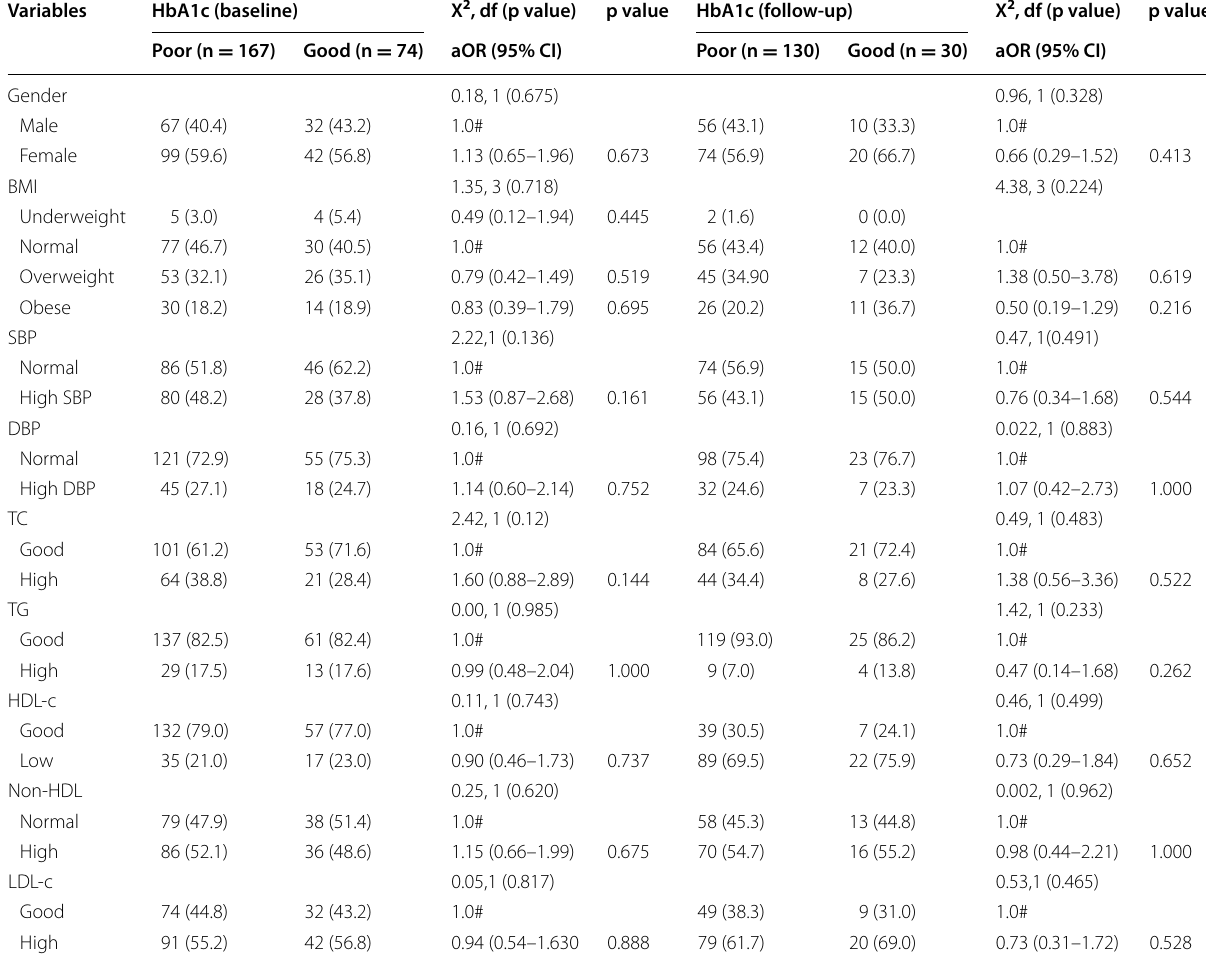
Logistic regression model, adjusted for age and medication. 1.0#: reference point for odds ratio